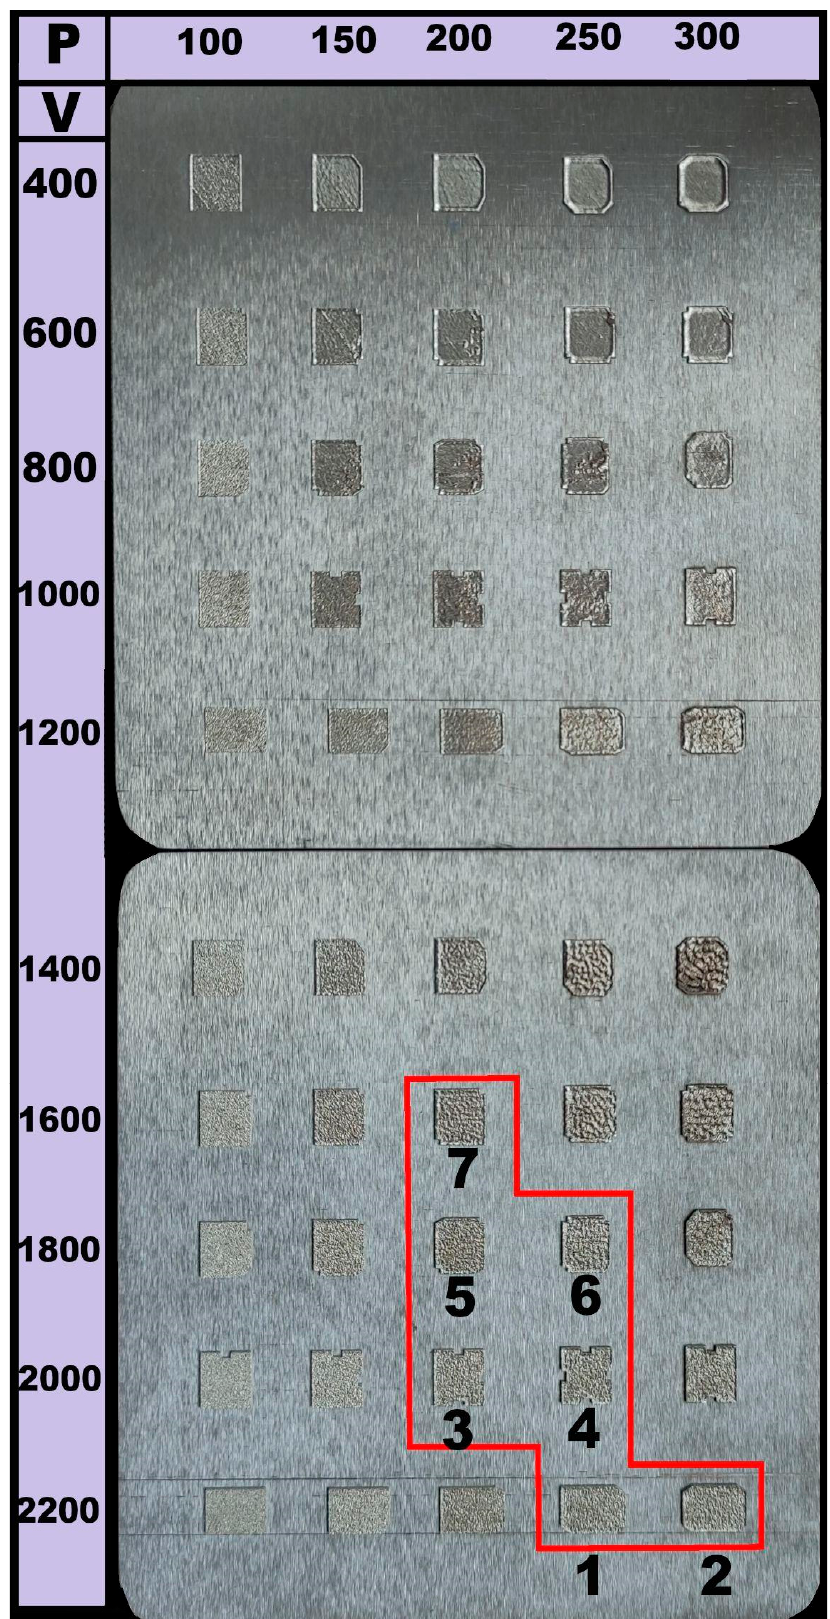
Figure 3. Selected parameters of SLM (laser beam power ( P ) and velocity ( V )). Table 2. Selected parameters of SLM (laser beam power ( P ), velocity ( V ), and energy density ( E ) calculated per Equation (1)).